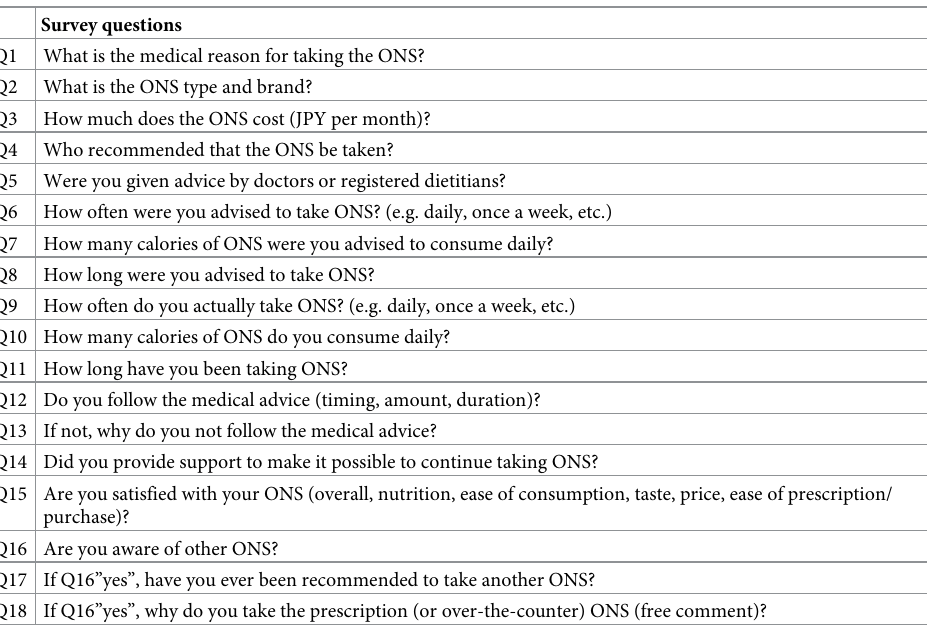
Table 1. Survey questions (excluding demographic